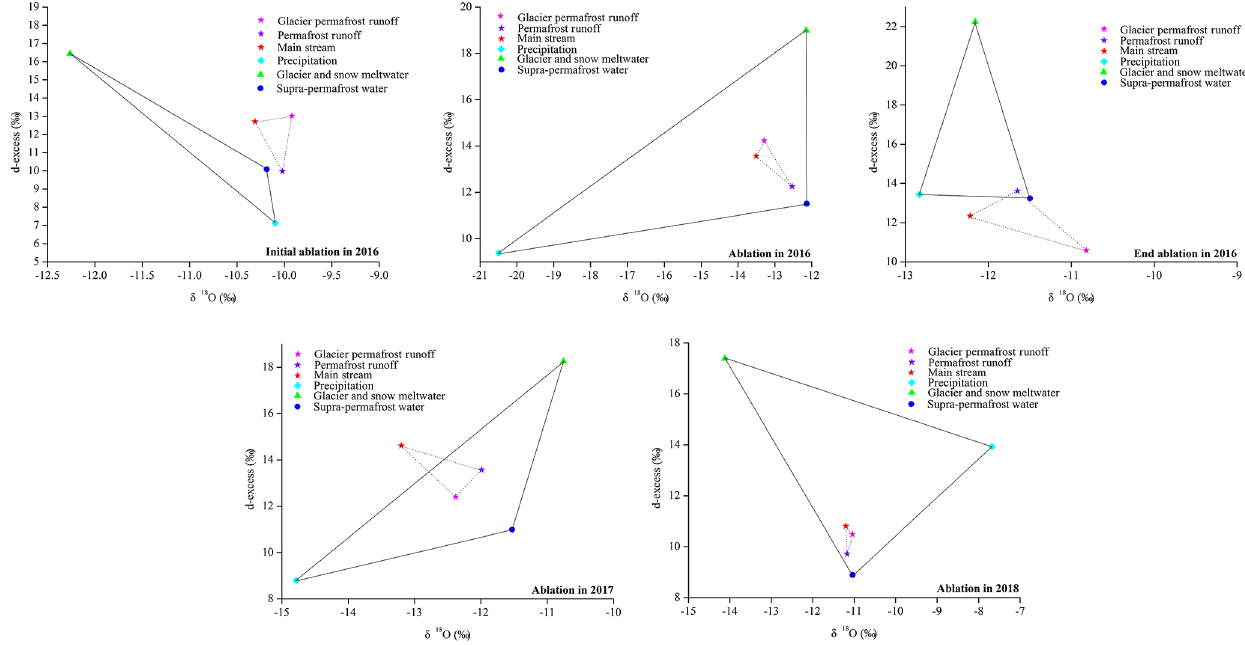
Figure 8. Three-end-element diagram using the mean values of δ 18 O and d -excess for river water in different ablation in 2016 and ablation from 2016 to 2018.